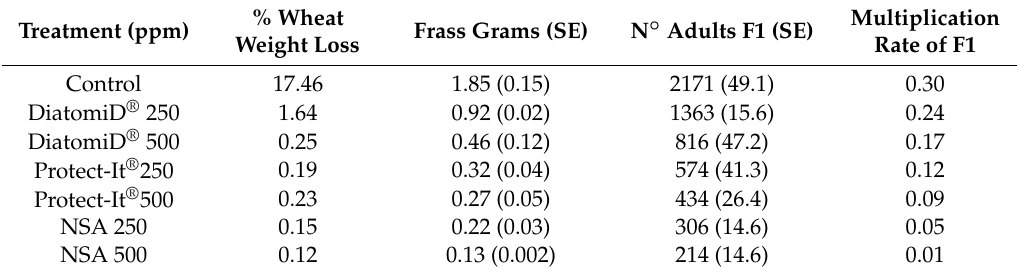
Table 2. Mean wheat weight loss, frass production, and number of adult of Sitophilus oryzae in F1 after 21 days of parental generation exposure and 42 days of development at 27 ± 1 ◦ C and 75% relative humidity (RH). MR is the obtained multiplication